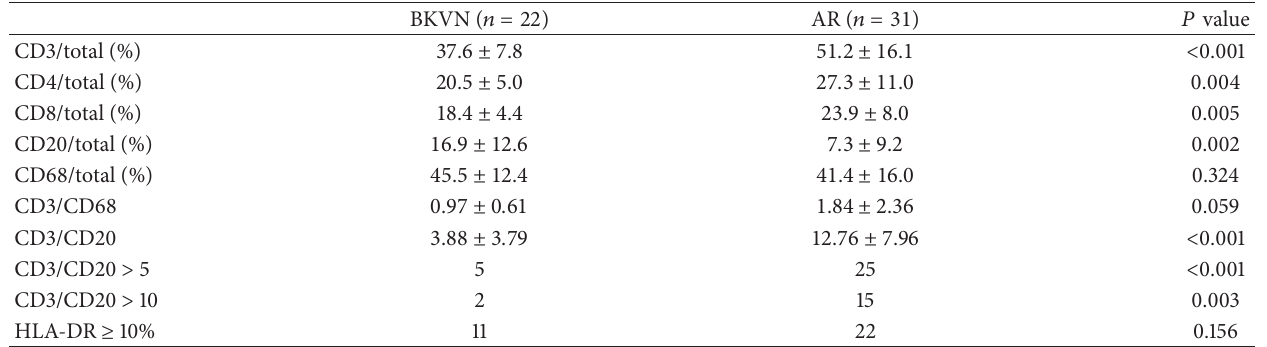
Table 3: Proportions of infiltrating lymphocytes and HLA-DR expression in BKVN and AR. BKVN ( 𝑛 = 22